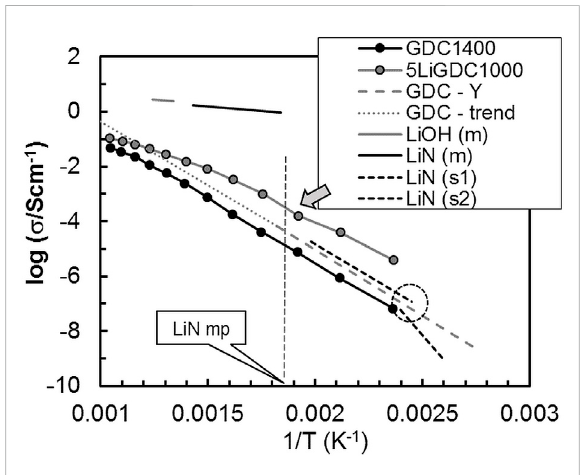
FIGURE 3 Total conductivity ( σ ) versus the reciprocal of absolute temperature (1/T) of GDC without and with LiN and possible secondary phases (Claes and Glibert, 1985; Yamashita et al., 1995; Skobelev et al., 1996; Zhu et al., 2014). See text for